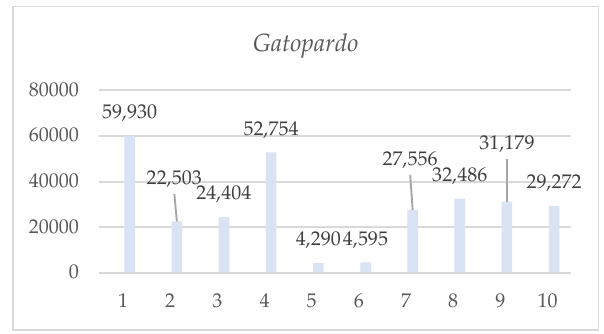
Figure 10. Length of articles on religion studied in Gatopardo .